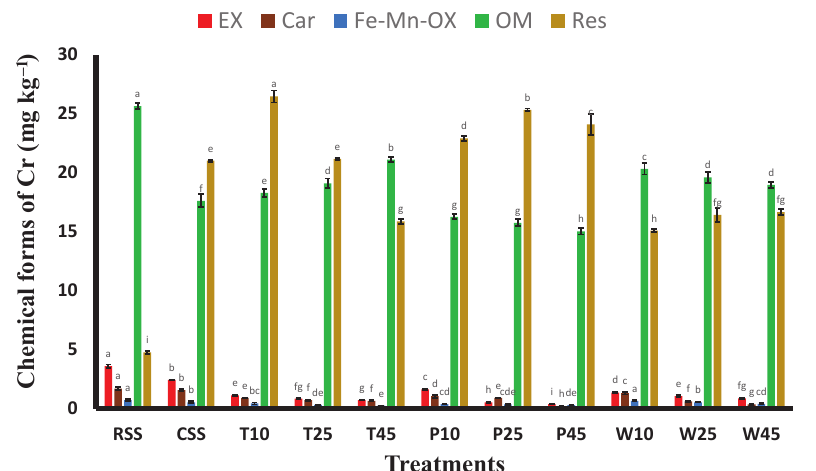
Figure 6: Chemical forms of Cr in RSS and produced compost samples. Different letters (in the same chemical forms of treatments) indicate significant differences among the mean of different treatments (p < 0.05). Error bars represent the standard deviation. (Each abbreviation in x-axis is defined in Table